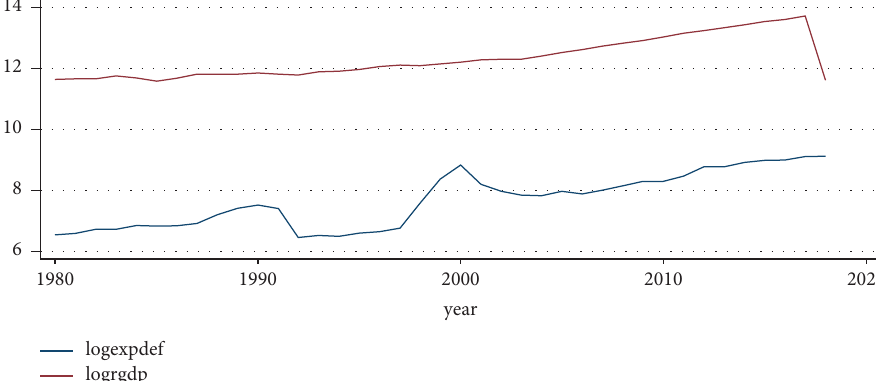
Figure 2: Trend of expenditure on defense and RGDP. Source: own computation based on the data from MOFED and National Bank, 2022.